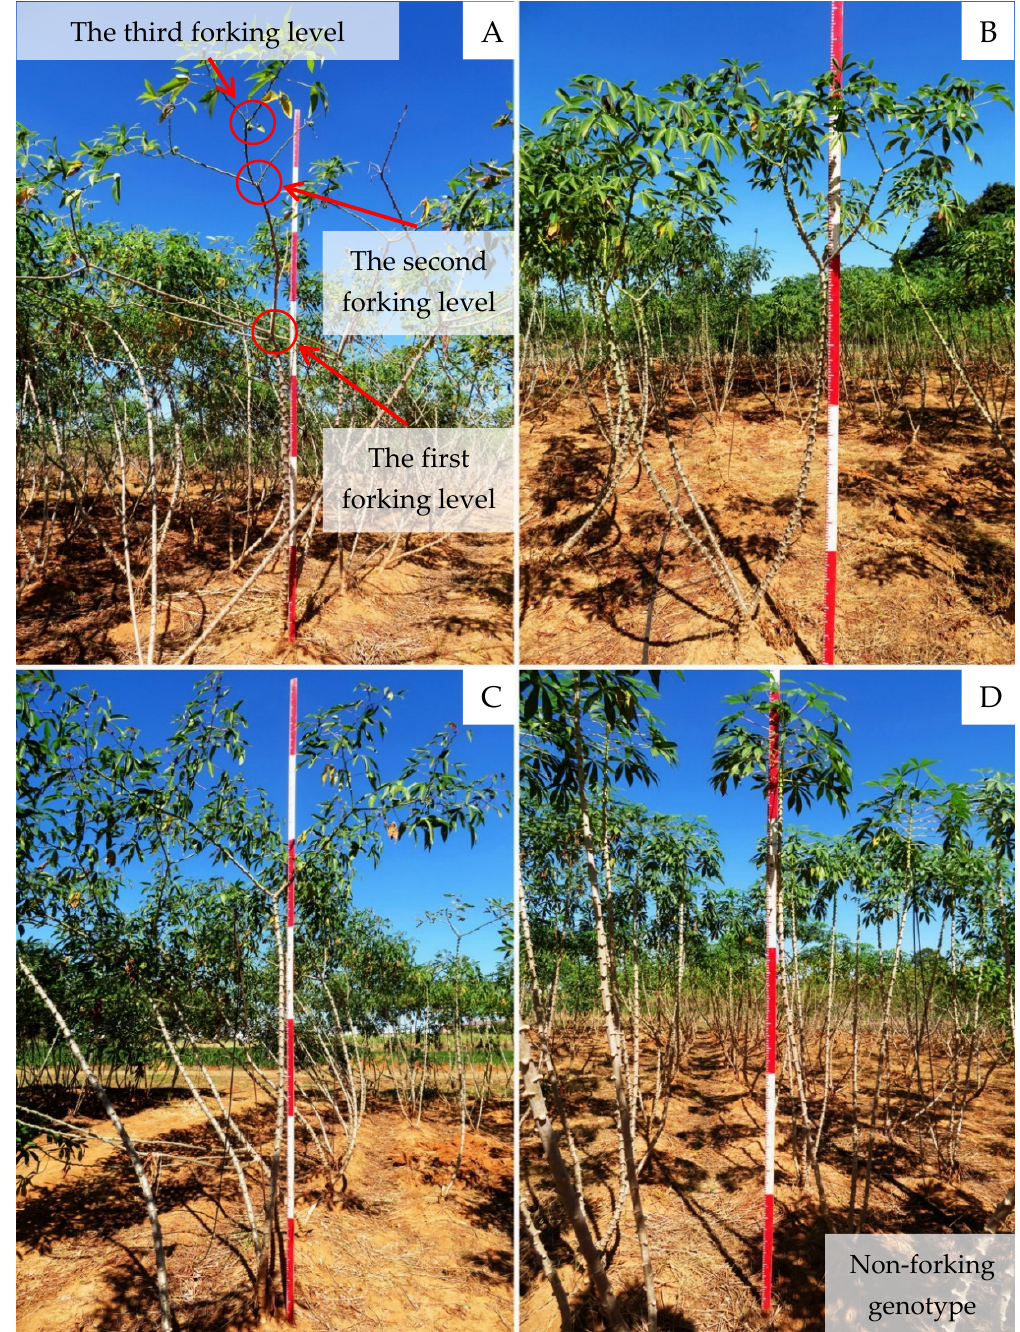
Figure 1. Forking pattern at 300 days after planting (DAP) for the Kasetsart 50 ( A ), Rayong 11 ( B ), CMR38–125–77 ( C ), and Rayong 9 genotypes ( D ) grown at the Khon Kaen University, Thailand.